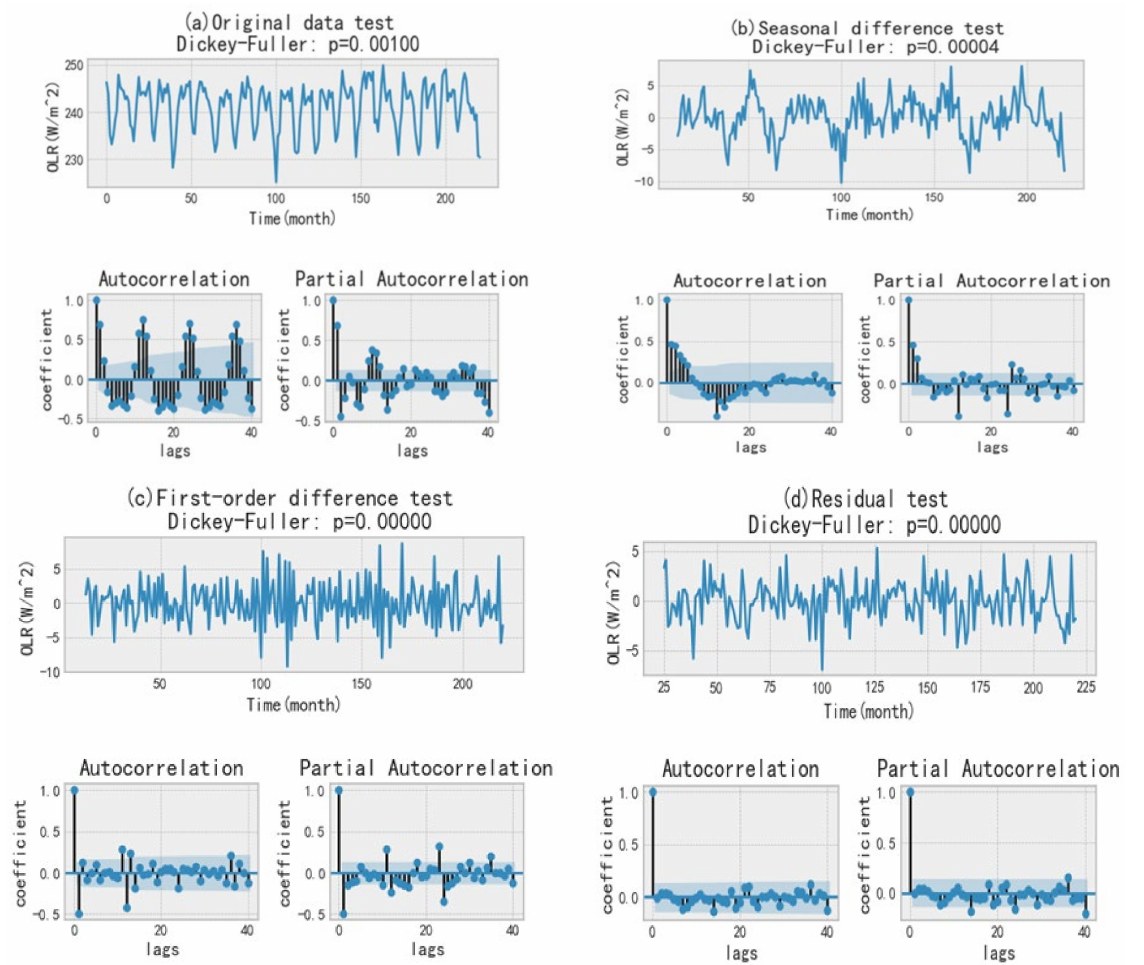
Figure 8. Stationarity test diagram. ( a ) Original data test. ( b ) Seasonal difference test. ( c ) First-order difference test. ( d ) Residual